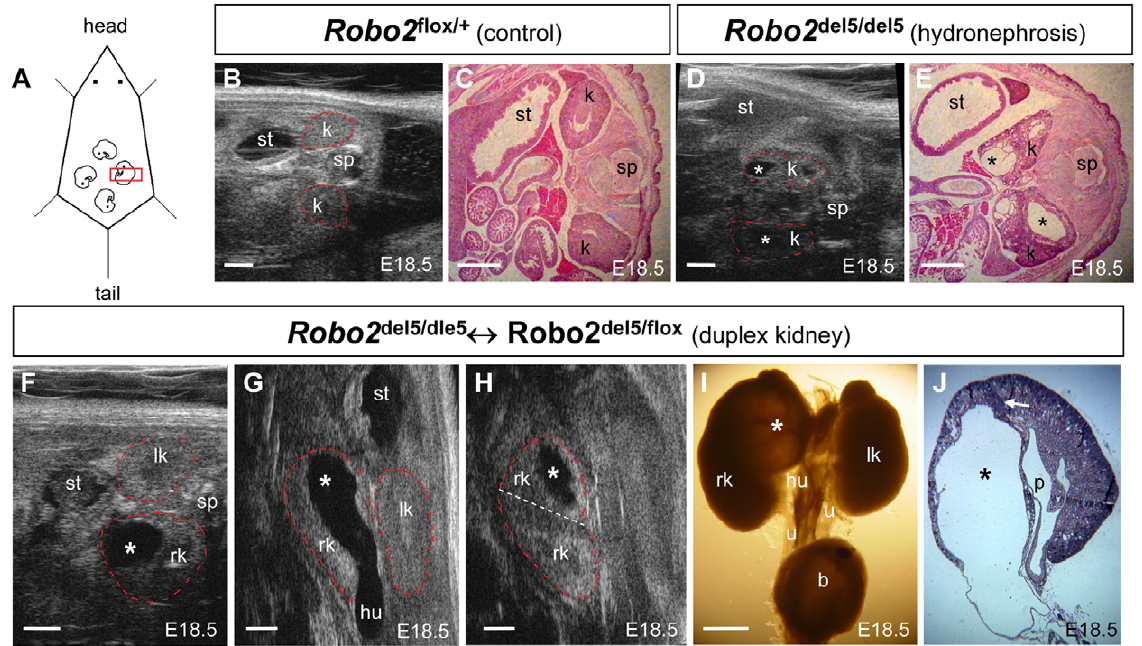
Figure 1. Noninvasive detection of antenatal hydronephrosis and duplex kidney in Robo2 mouse embryos. The outline of the kidneys depicted in ultrasound images were marked by red dot line. ( A ) Schematic diagram of ultrasound detection of mouse embryonic kidney in pregnant mice; 4 schematic embryos inside a pregnant mouse were shown; red square represented the ultrasound scanhead. ( B , C ) Normal E18.5 mouse embryonic kidneys detected by Vevo 770 ultrasound (B) and H&E histology confirmation (C). ( D , E ) Ultrasound detection of antenatal hydronephrosis (asterisks) in an E18.5 Robo2 homozygous embryo (D) and H&E histology confirmation (E) showing bilateral dysplastic kidney with hydronephrosis (asterisks). ( F – J ) Ultrasound detection of prenatal duplex kidney and upper pole hydronephrosis with hydroureter in an E18.5 Robo2 mosaic embryo. Antenatal hydronephrosis (asterisks) in the upper pole of right kidney (rk) of an E18.5 Robo2 mosaic embryo detected with B-mode ultrasound in transverse plane (F), ventral coronal plane (G) and dorsal coronal plane (H). A normal left kidney (lk) was also detected in the transverse plane (F) and ventral coronal plane (G). The hydronephrosis (asterisks) in the upper pole of right kidney (rk) was connected to an enlarged hydroureter (hu) in (G). A dorsal coronal plane (H) showing upper and lower right duplex kidney (divided by an artificial white dot line) as well as upper pole hydronephrosis (asterisks). (I) Gross structure of the urinary tract system from the same E18.5 Robo2 mosaic embryo examined by ultrasound in (F–H) showing enlarged right duplex kidney with upper pole hydronephrosis (asterisks) connected to an enlarged hydroureter (hu). The right duplex kidney and upper pole hydronephrosis (asterisks) in this E18.5 Robo2 mosaic embryo was confirmed by H&E histology (J); a white arrow depicting internalized nephrogenic zone (renal cortex) separating upper and lower duplex right kidney. Scale bars, 1.0 mm. Abbreviation: b, urinary bladder; k, kidney; lk, left kidney; rk, right kidney; p, renal pelvis; sp, spine; st, stomach.